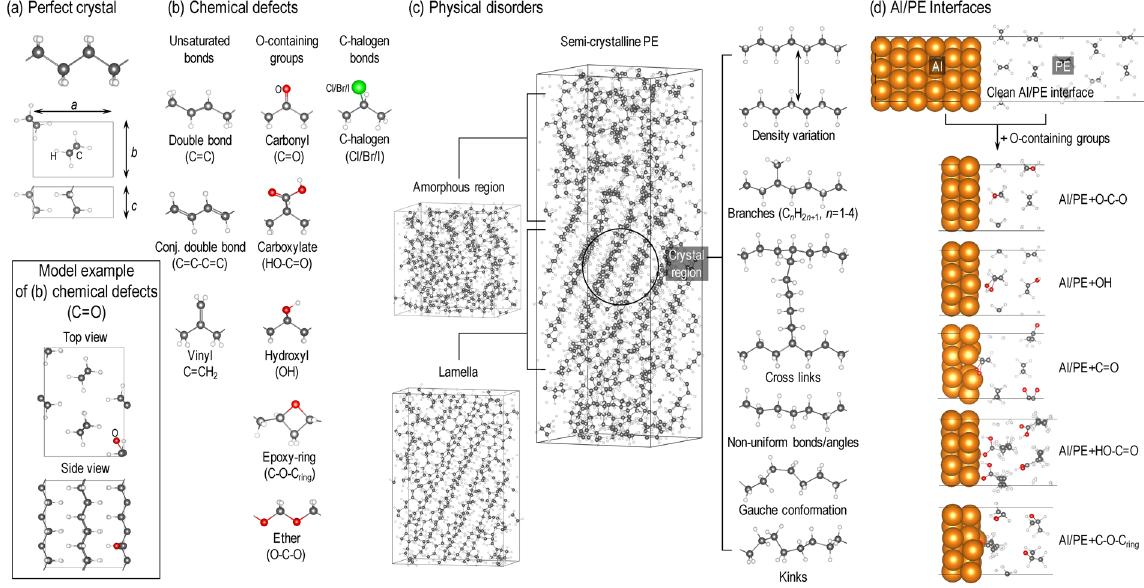
Figure 2. Sketched structures of the perfect crystalline PE ( a ), PE chemical defects ( b ), PE physical disorders ( c ), and Al/PE interfaces ( d ) considered in this work. Al, C, H and O atoms are shown in gold, black, white, and red,